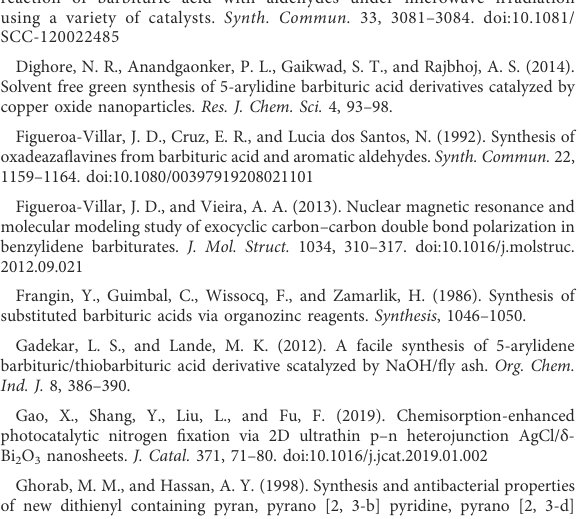
Figueroa-Villar, J. D., and Vieira, A. A. (2013). Nuclear magnetic resonance and molecular modeling study of exocyclic carbon – carbon double bond polarization